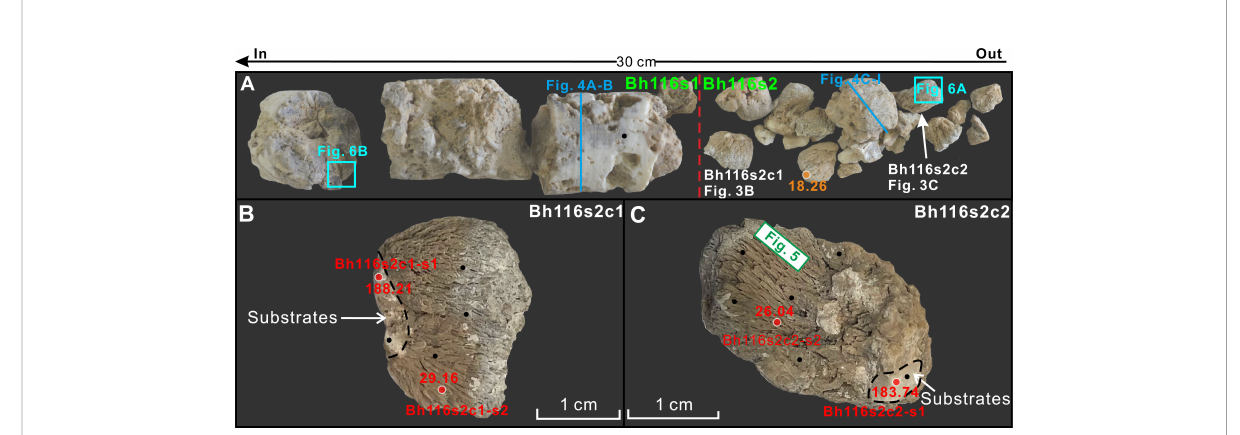
FIGURE 3 Photographs of sample Bh116 (A) and two subsamples (B, C) showing locations for thin section (blue lines;Figure 4), scanning electron microscopy (green rectangles; Figure 5), XRD (cyan rectangles; Figure 6), carbon and oxygen isotopes (black circles; Figure 7), U – Th dating (red circles; Table 1), and radiocarbon dating (orange circles; Table 1). The dotted red lines in (A) divide the core samples into substrates and speleothems, i . e ., Bh116s1 and